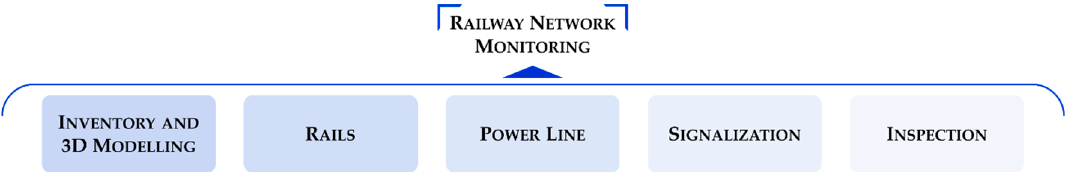
Figure 7. Classification of the railway network monitoring based on the application.